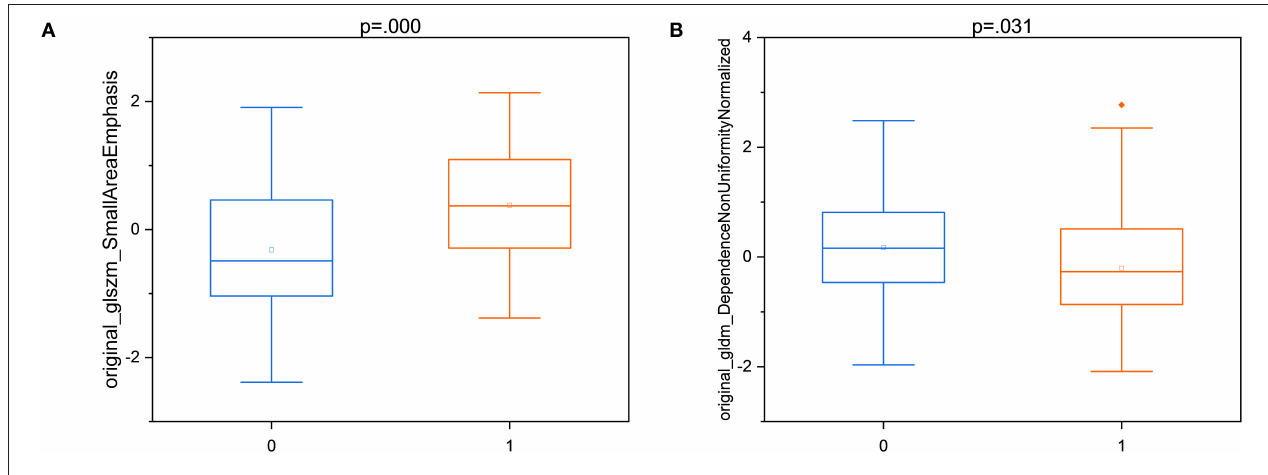
FIGURE 6 | The box plots of two “good” T2WI-HCR of T2WI-DLR with the results of the statistical test. (A) original_glszm_SmallAreaEmphasis; (B) original_gldm_DependenceNonUniformityNormalized. Brain abscess:0; Cystic glioma:1. Supplementary Table 7 . The RQSs of the relevant work